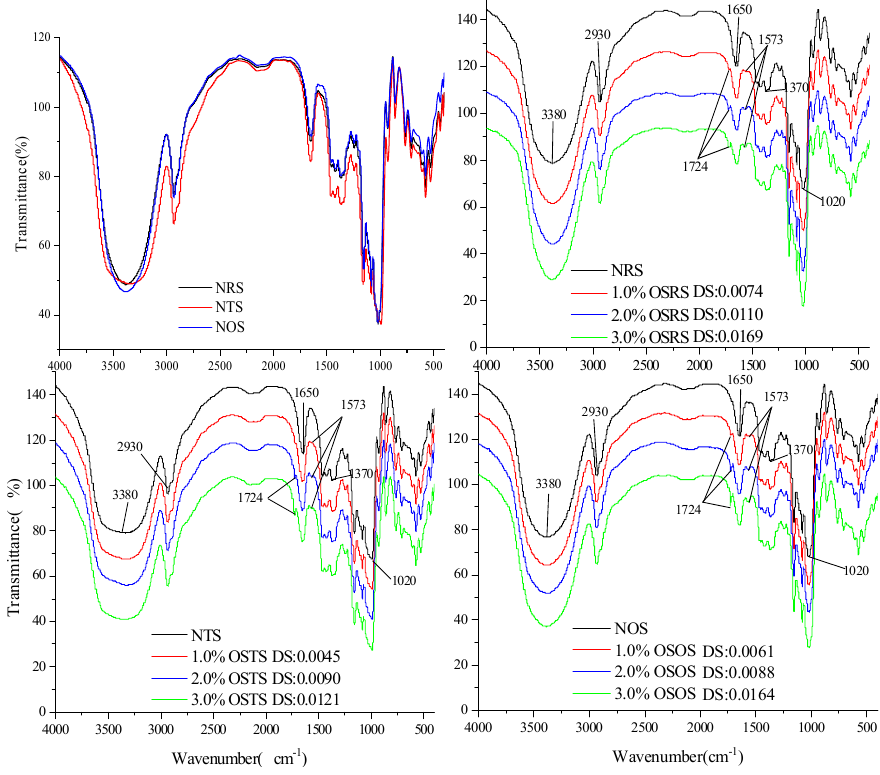
Figure 4. FT−IR spectra of NS and OS-starch. Figure 4. FT − IR spectra of NS and